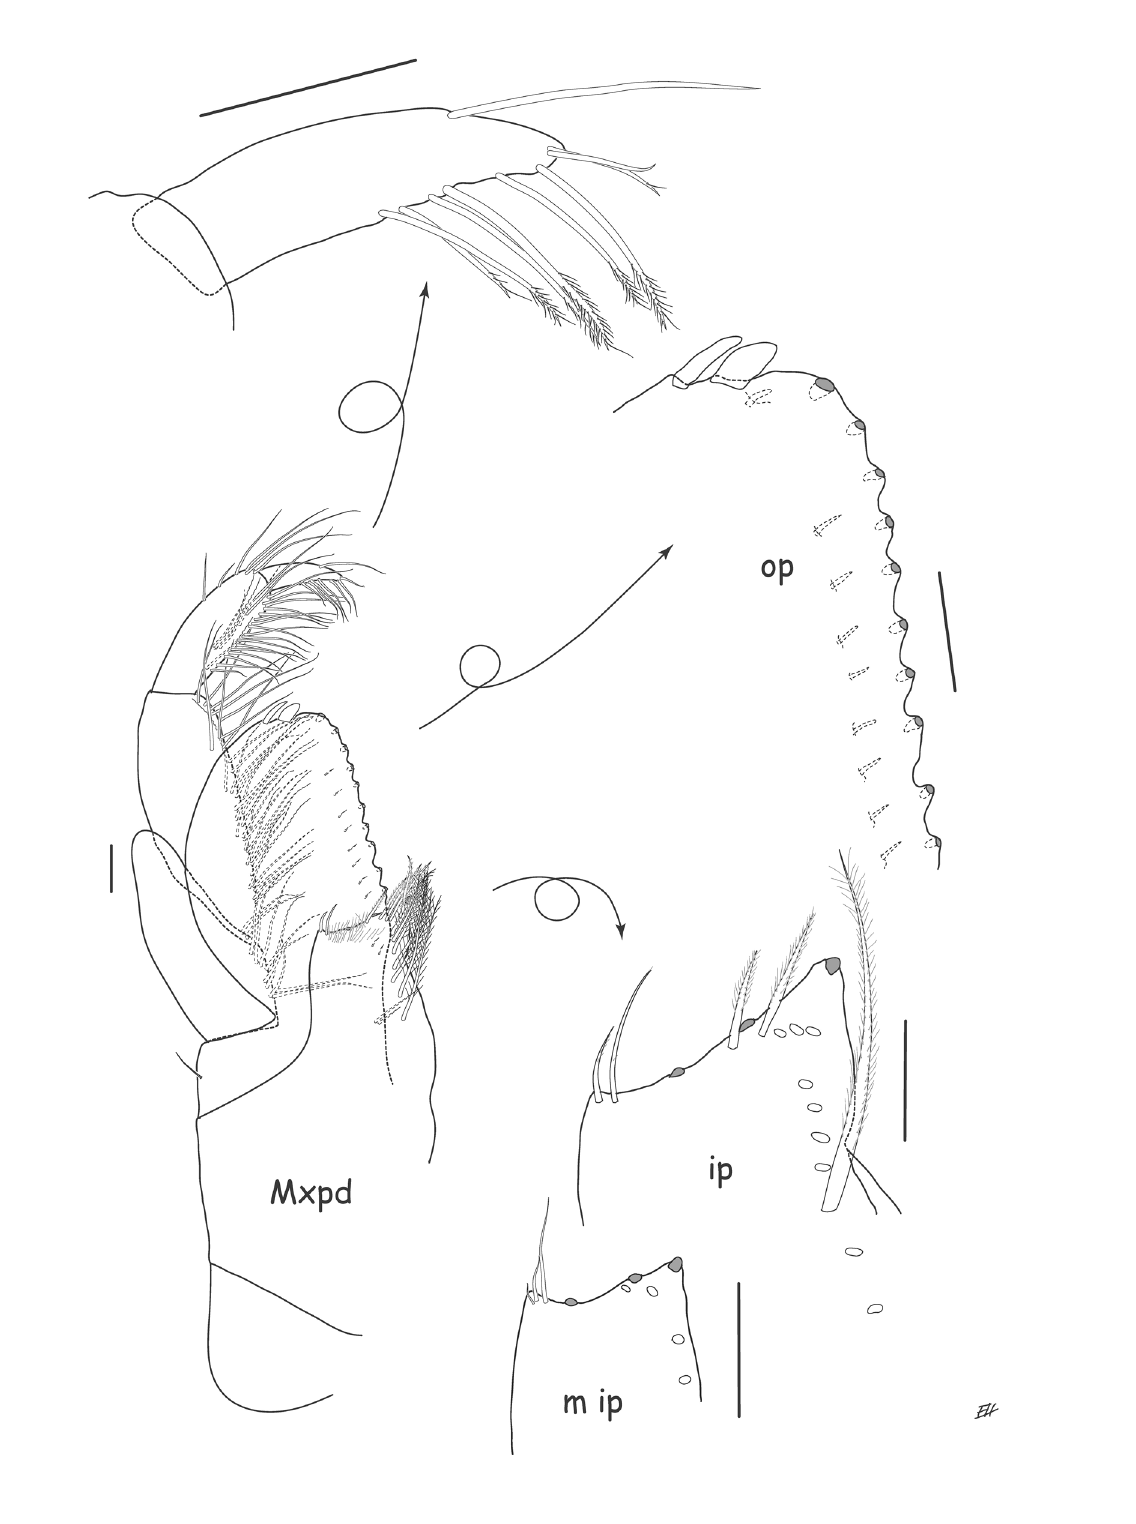
Fig. 30. Abyssorchomene shannonae sp. nov., holotype, ♀, 12 mm (ZMH K-61209); allotype, ♂, 7 mm (ZMH K-61210). Figures with sex not indicated are of female. Scale bars = 0.1